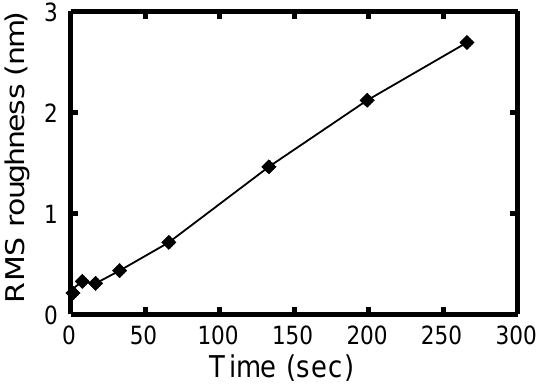
Figure 2. RMS roughness of Ar/O etched PS with bias voltage of −10 V and etch times 2 from (a) 0 seconds to (h) 266 seconds, corresponding to approximate etch depths (a) 0